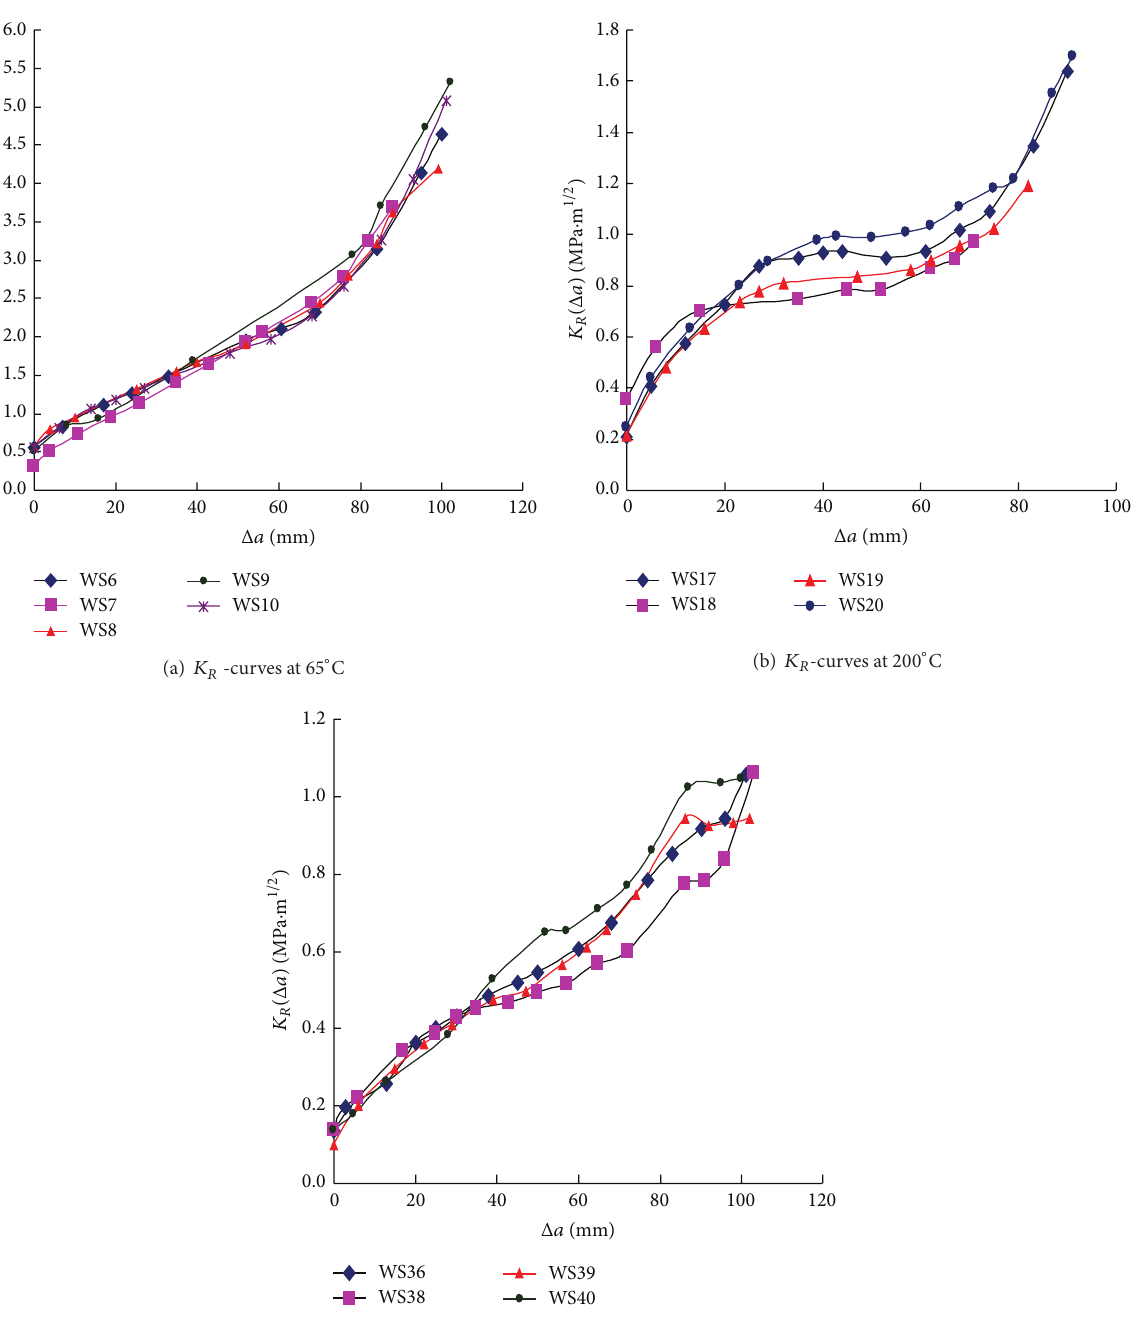
are plotted on the vertical axis in Figures 11(a) ∼ 11(d).